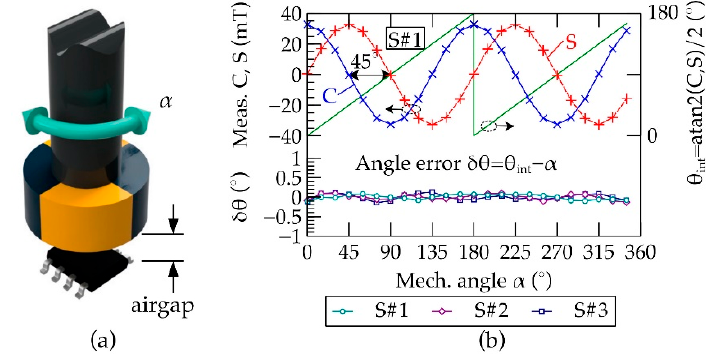
Figure 4. ( a ) Schematic representation of the measurement setup. ( b ) Measured sensor signals C and S of sample S#1 showing an amplitude of about 33 mT at a field gradient of G = 20 mT/mm. Consequently, a magnetic concentrator gain of gC = 0.83 mm was found. As expected, the calculated angular position θ int was confirmed to alternate twice for a full 360° rotation and its deviations δ θ from the mechanical reference α were found to be below 0.3°. For the sake of legibility, results of three samples S#1, S#2, and S#3 are shown.